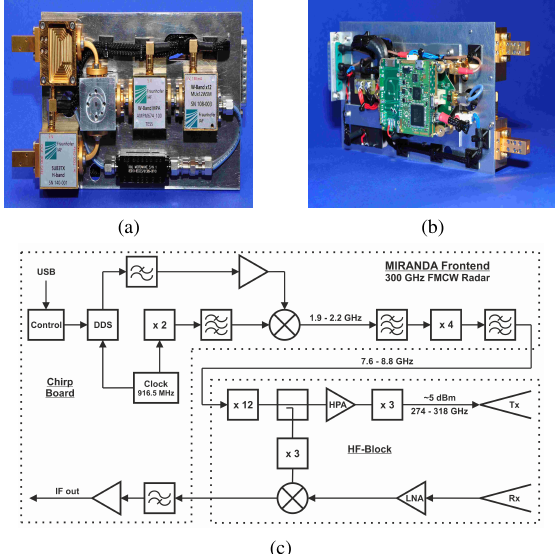
Figure 2: MIRANDA-300 radar system: (a) Photograph of the high frequency view. (b) Photograph of the chirp generation view. (c) Block diagram of the front-end design. Dimensions are 20x10x10 cm with a weight of 1.5